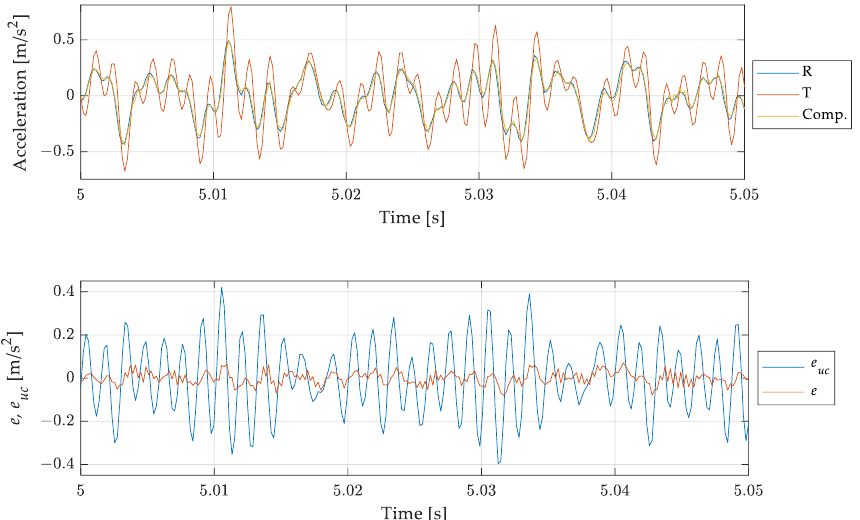
Table 2. Test case 3. Frequencies for the multi-harmonic signal. Refer to Figure 8 and Table 1 for device under test data.